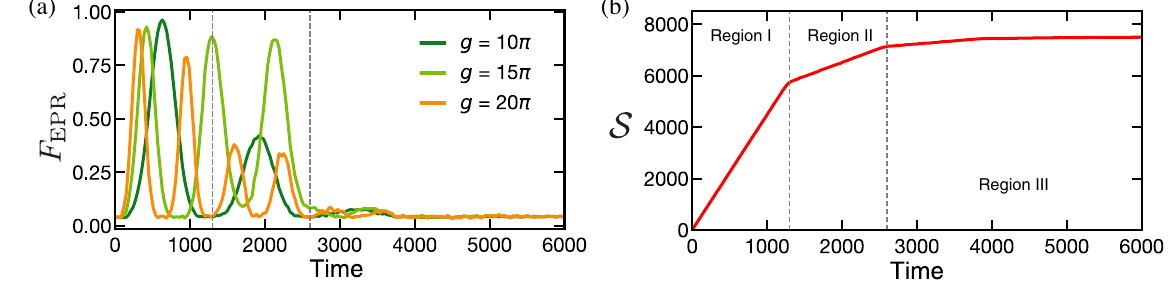
FIG. 11. Teleporting multiple qubits ( n ¼ 5 ) in 1D, where the input qubits are evenly spaced in the system ( N ¼ 10000 ). (a) Teleportation is achieved with high fidelity for t ≤ 1300 (region I). This corresponds to the regime in which the light cones of the operators are nonoverlapping. Interestingly, order-one fidelity can also occur for 1300 < t < 2600 (region II), when adjacent light cones have overlapped, but only for certain values of g . No multiqubit teleportation is possible for t ≥ 2600 (region III), as expected from the lack of size addition. (b) The three regions can be detected by changes in the slope of the operator size as a function of time. In particular, the growth rate decreases when nearest-neighbor light cones, then next-nearest-neighbor light cones, etc., begin to